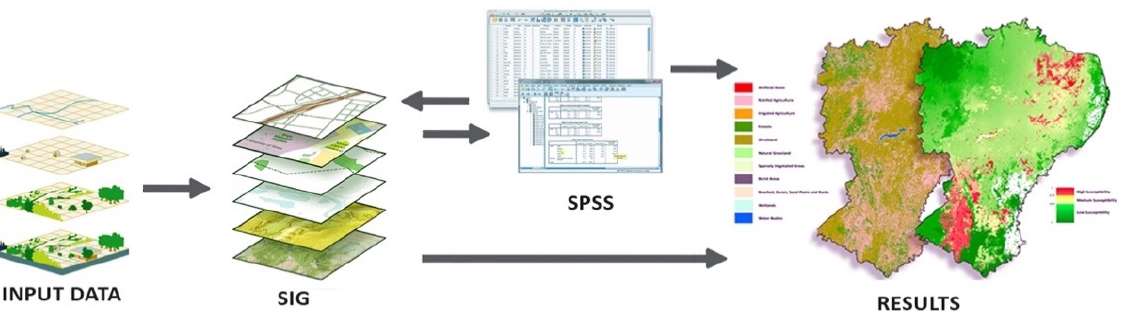
Figure 1. Data treatment–general methodology.